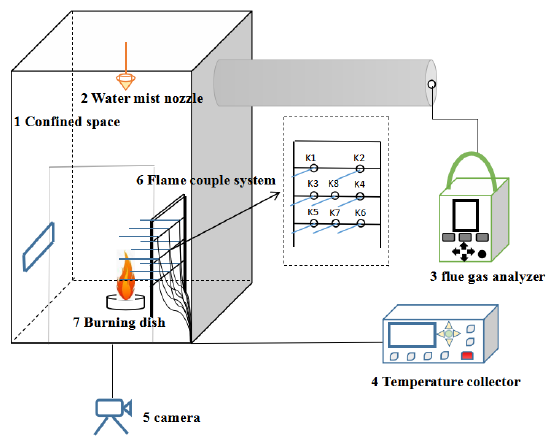
Figure 1. Diagram of the experimental system.